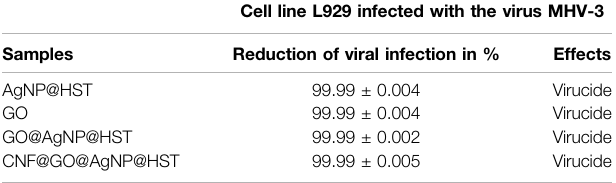
TABLE 2 | Toxicity data of the tested nanomaterials/composites.